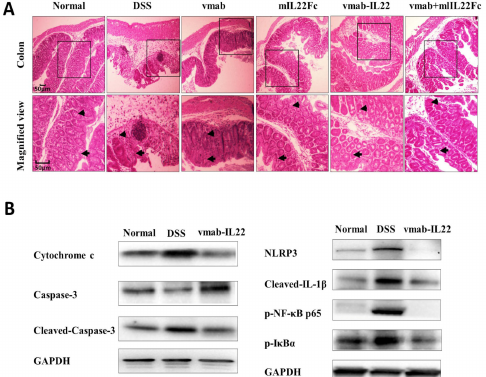
Figure 6. Vmab-mIL22 treatment attenuates the damage to the intestinal barrier and regulates apoptosis and inflammatory pathways in DSS-induced mice. ( A ) Pathological changes in the colon were evaluated using H&E staining. Intestinal villi morphology (arrow) and intestinal inflammatory infiltration (triangle) were indicated. ( B ) Western blot analysis of cytochrome c, caspase-3, cleaved caspase-3, NLRP3, cleaved-IL-1 β , p-NF- κ B p65 and p-I κ B- α in expression in the colon in DSS-induced colitis mice. NLRP3, NOD-like receptor thermal protein domain associated protein 3; p-NF- κ B p65, phospho nuclear factor-kappa B; p-I κ B α , phospho inhibitor of nuclear factor (NF)- κ B- α ; GAPDH, glyceraldehyde-3-phosphate